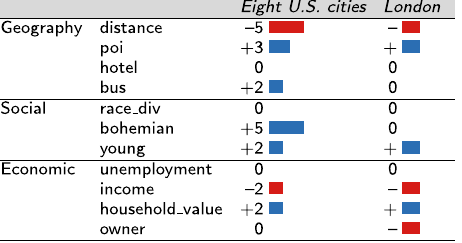
Table 6 Comparison of results between the eight analyzed U.S. cities and London, UK